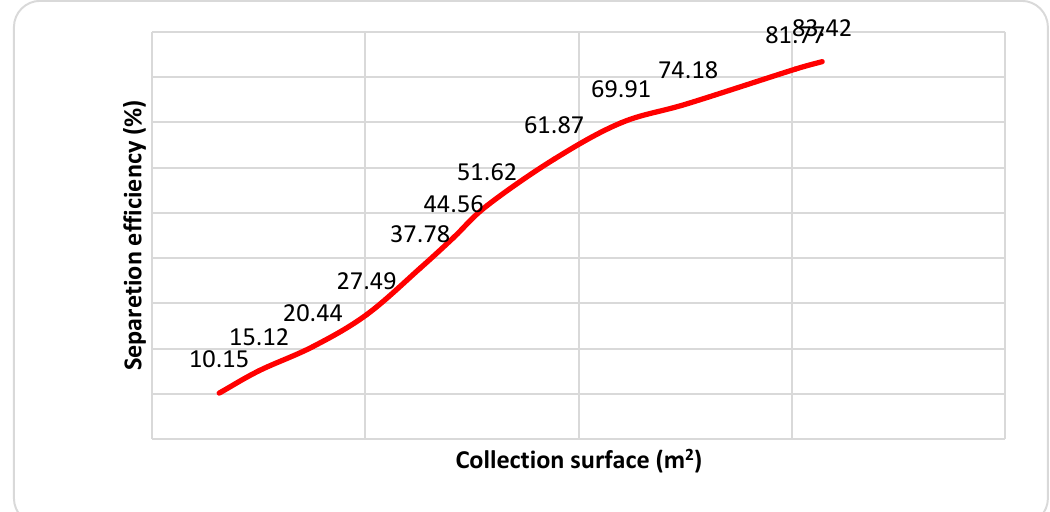
Figure 9. Graphical dependence of separation efficiency on the size of the collection surface. The standard stainless-steel chimney with a diameter of 200 mm and collection surface of 0.628 m 2 per meter compared to the new improved model with four 120 mm pipes with a collection surface of 1.508 m 2 represents almost 2.4 times magnification. The distribution of the flue gas stream into smaller pipes also leads to a more efficient and stable effect of the electrostatic field on the particle [22,23], which is also confirmed by the mathematical model results shown in Figure 10.